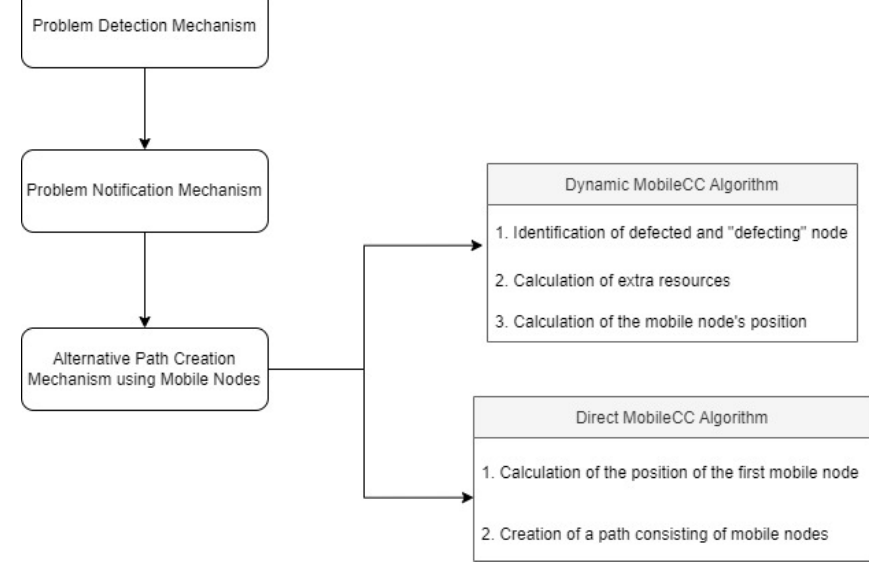
Figure 1. Block Diagram of the